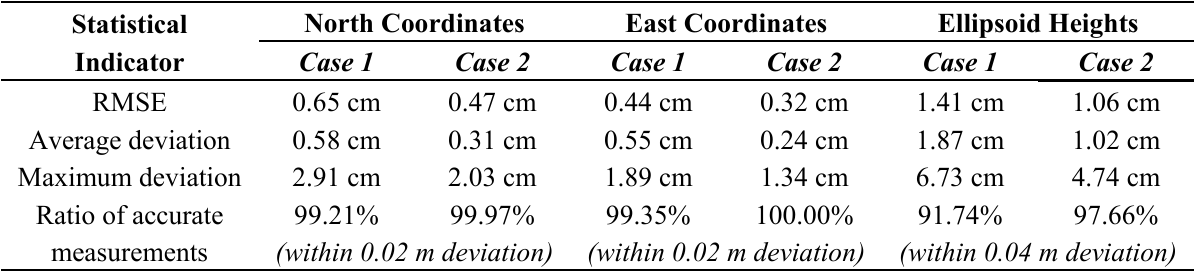
Table 5. Statistical indicators of the filtering effects for use of random and autocorrelation error model in NRTK